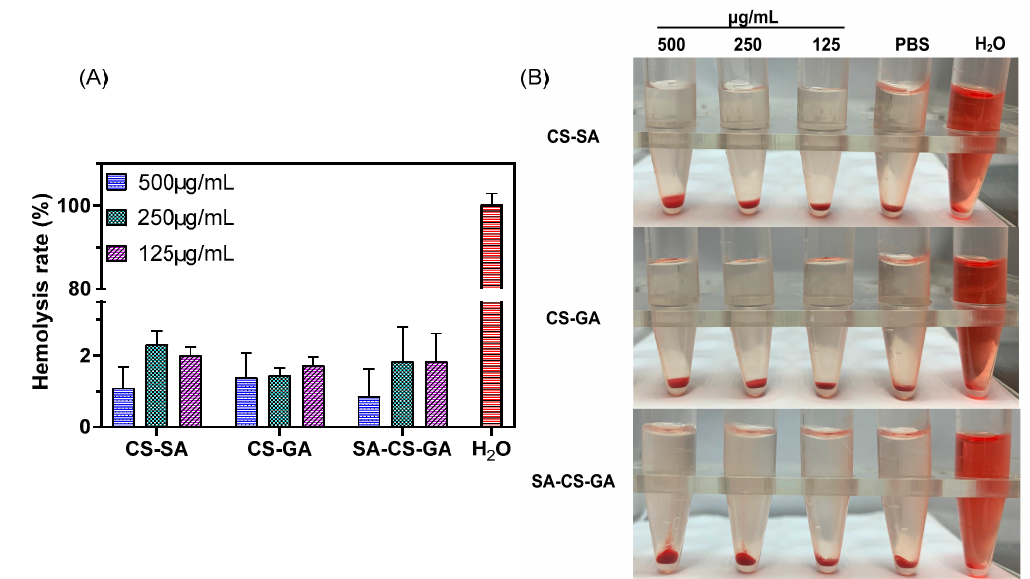
Figure 5. Hemocompatibility of novel chitosan derivatives at different concentrations. ( A ), hemolysis rate; ( B ), hemolysis photograph. Data are presented as mean ± SD of three independent experiments.